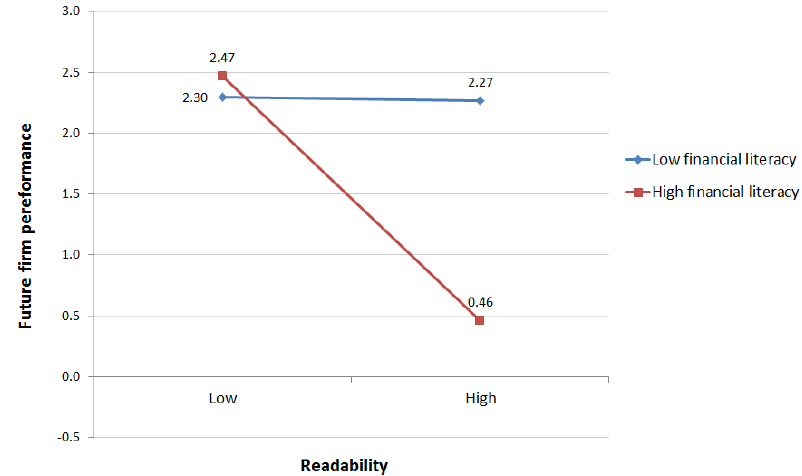
Figure 1. Plot of Readability–FinLit (Financial Literacy) interaction on change of future earnings performance judgment.